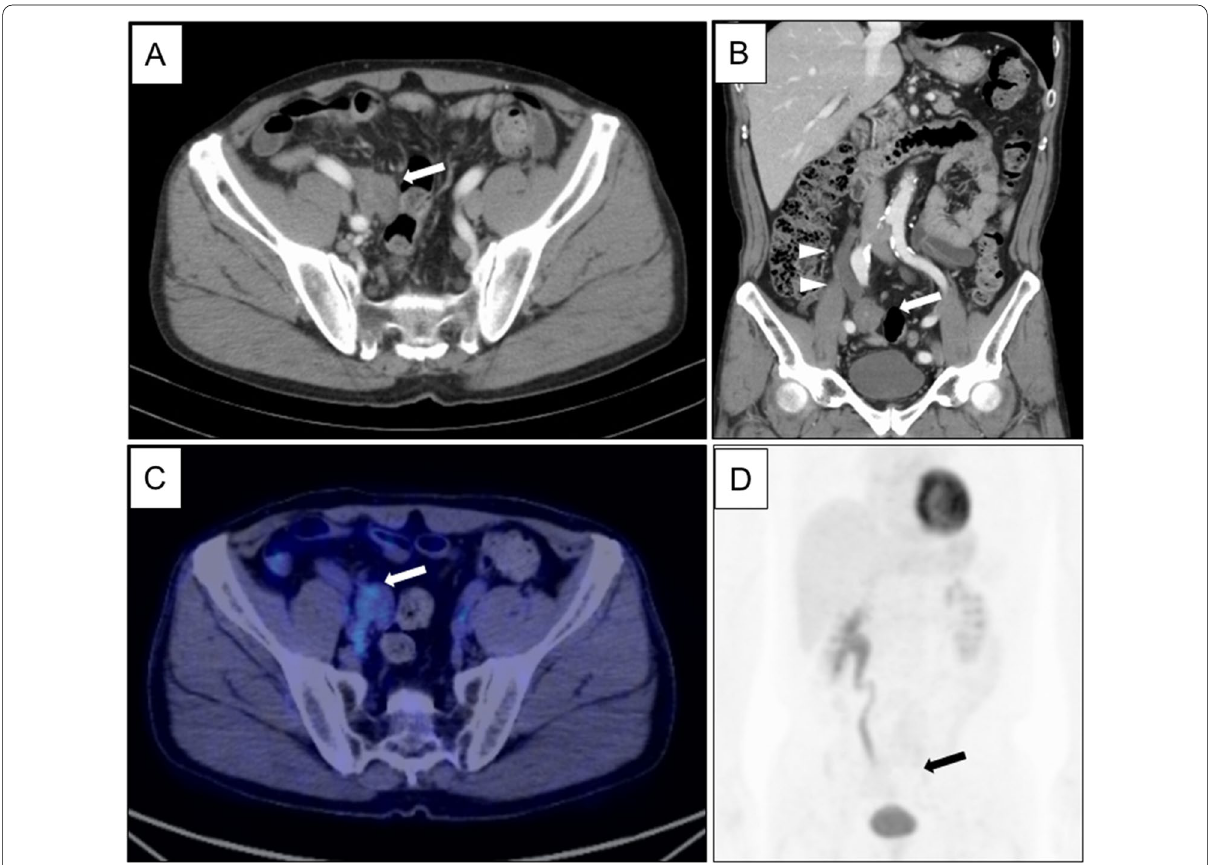
Fig. 1 Contrast-enhanced computed tomography (CT) and positron emission tomography/computed tomography (PET/CT). Contrast-enhanced computed tomography (CT) scan showed a mass-forming lesion on the right external iliac artery (43 hydronephrosis ( B arrowhead). Positron emission tomography/computed tomography (PET/CT) showed a mass-forming lesion without high accumulation ( C arrow), which obstructed the ureter ( D